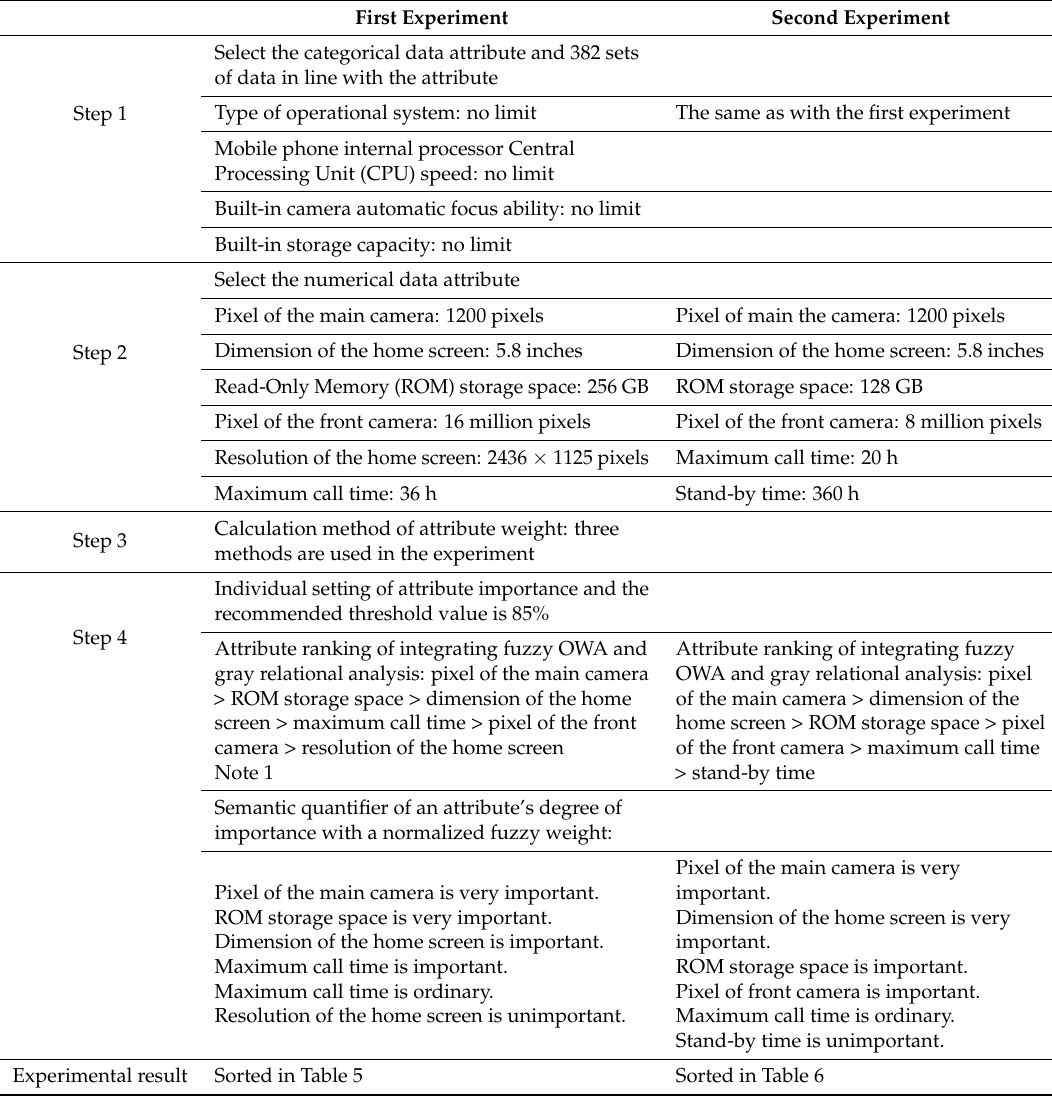
Table 1. Condition setting of the two experiments with the conformity